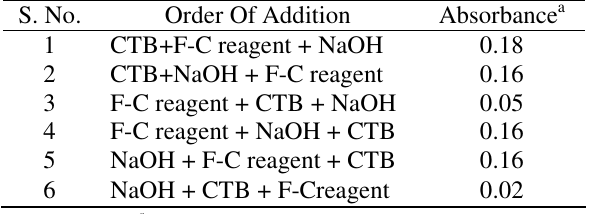
Table 1. Effect of order of addition of reactants on color